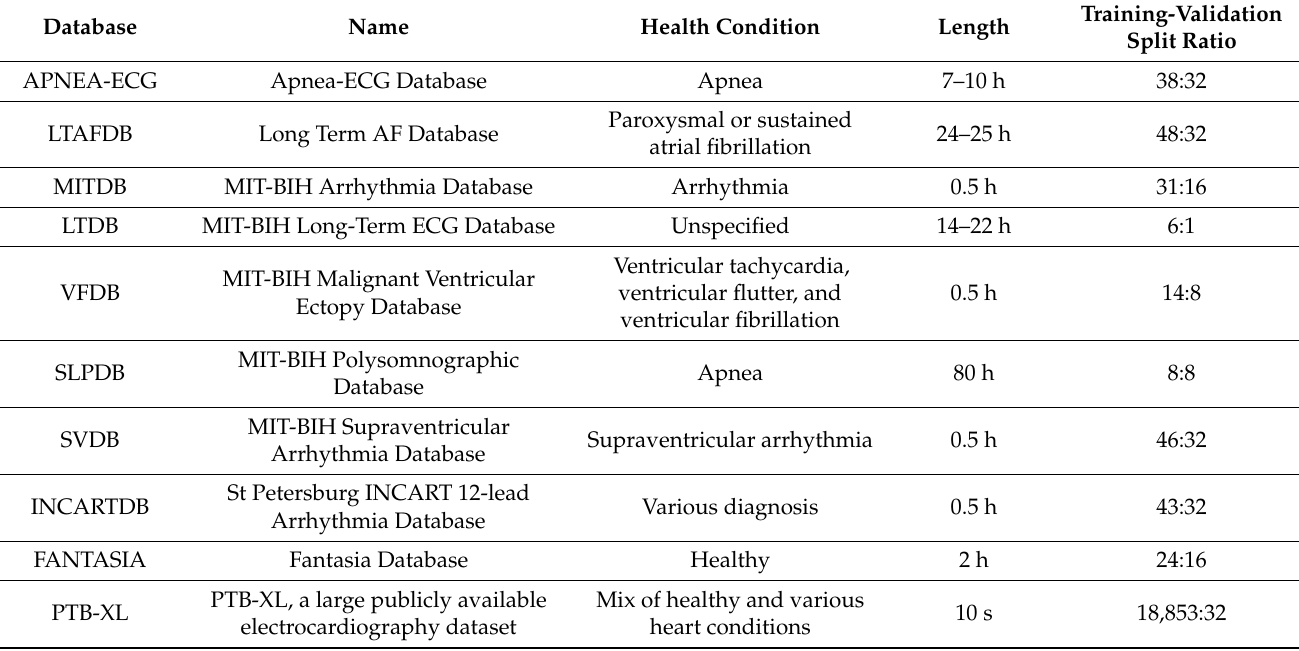
Table 4. ECG databases used to generate training and validation